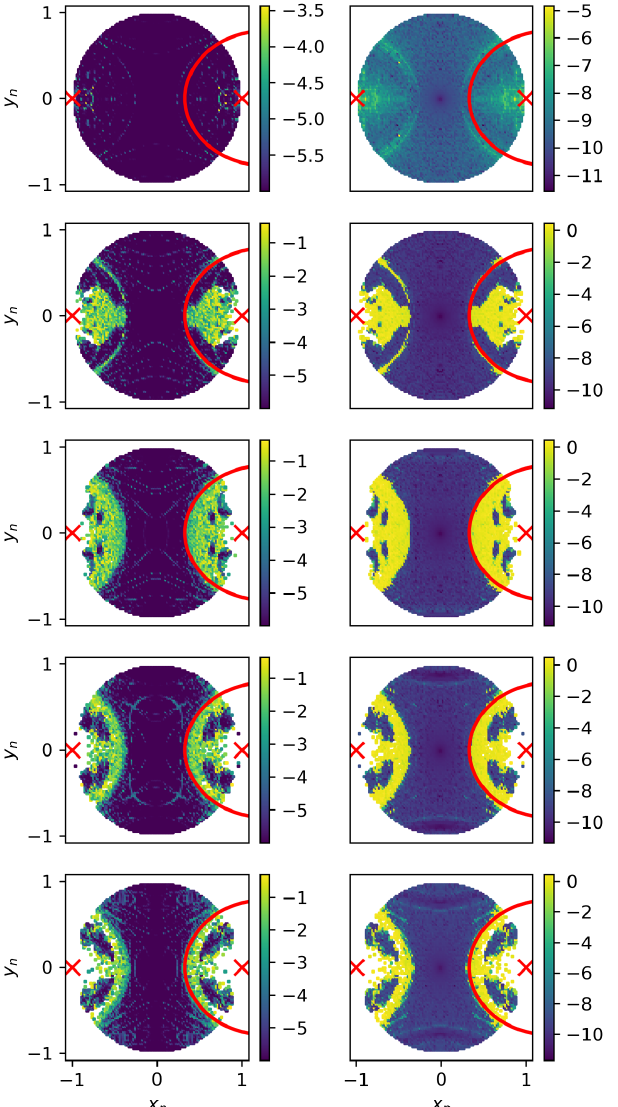
FIG. 14. Dynamic aperture plots for the IOTA toy-model at ν ¼ 0 . 3 , τ ¼ − 0 . 4 and various δμ with a fixed number of turns FIG. 16. Comparison of FMA and REM for varying number of T ¼ 1024 for each interval. Two successive forward intervals are turns T per tracking interval at δμ ¼ 0 . 01 . The phase-advance used for FMA, while one forward and one backward interval are over the nonlinear magnet section is fixed at ν ¼ 0 . 3 . The color used for REM. The color maps in the left and right columns are Δ bars of the left and right columns scale with Δ , and Δ respectively. From top to bottom δμ is FMA REM respectively. The time interval is T ¼ 256 (top) and T ¼ 2048 increasing from 0.0 to 0.04 in increments of 0.01. Red x-marks denote the singular points of the nonlinear insert potential. The red curve is where I ¼ 2 H . We draw the red curve only on the x > 0 side for dynamic aperture visibility, but the I ¼ 2 H curve n visibility by increasing contrast with the resonant lines. The < 0 , due to the reflection should also be present on the side x n lines indicate resonances of the ideal (unperturbed) system. symmetry of H and I .